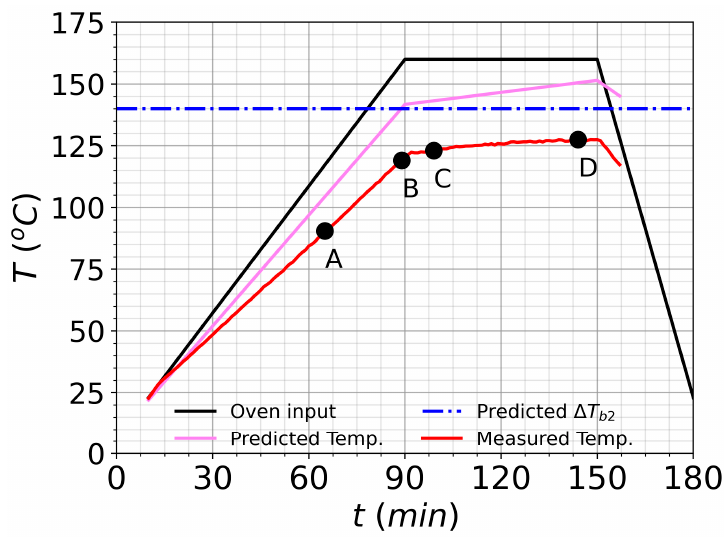
Figure 16. Heating cycle for [35/−35/10/−10] (cid:3046) composite plate.